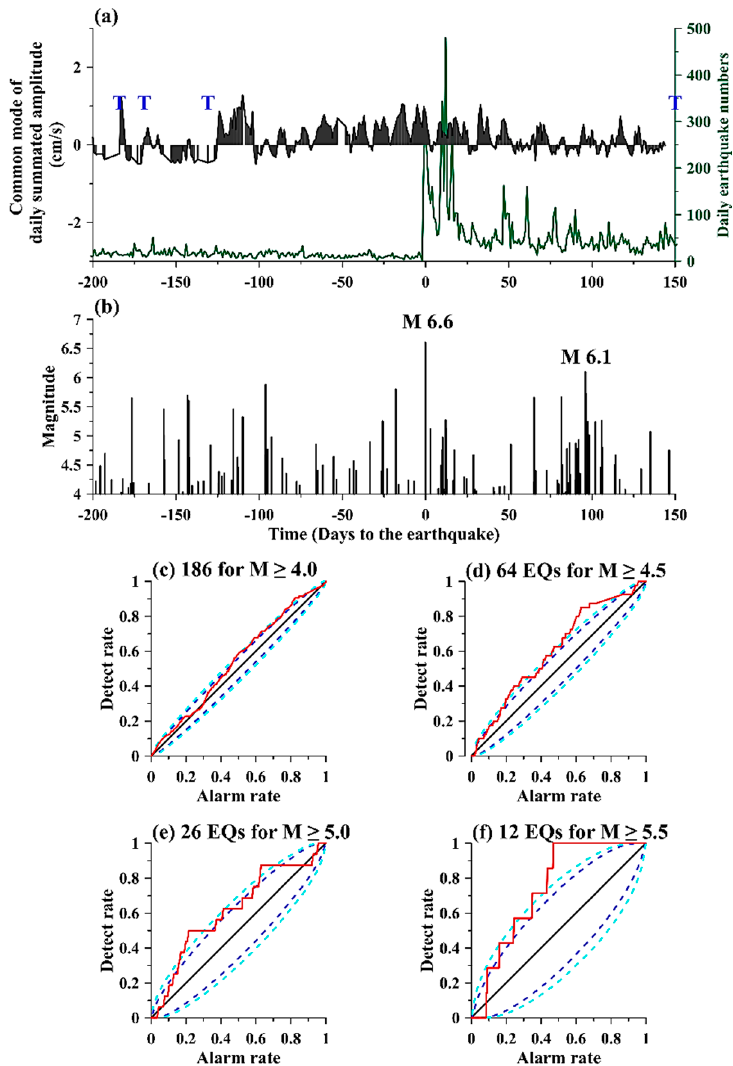
Figure 6. The common mode of daily summated amplitude from 200 days before to 150 days after the Meinong earthquake. The common-mode vibrations are determined by using the first principal components retrieved from the PCA method shown in ( a ). The green line reveals the daily count of earthquakes in the Taiwan areas. T marks (in blue) indicate the time that typhoons impacted Taiwan. Occurrence times of earthquakes with magnitude ≥ 4 during the study period are shown in ( b ). Two major earthquakes with magnitude ≥ 6.0 are marked. The associated information is shown in Table 1. ( c – f ) demonstrate Molchan’s error diagrams of the optimal prediction strategy based on the first principal component versus to earthquakes with di ff erent criteria of their magnitude. The prediction curve shown by the red line is clearly above the random prediction line given by the black diagonal line. The 90% and 95% confidence intervals are shown by the dashed dark blue and dashed blue lines,